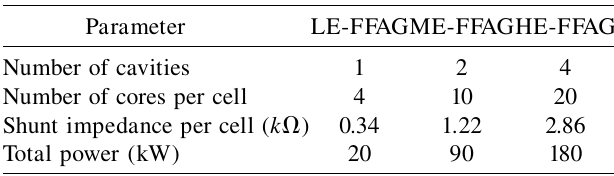
TABLE VIII. Basic parameters of rf cavity.